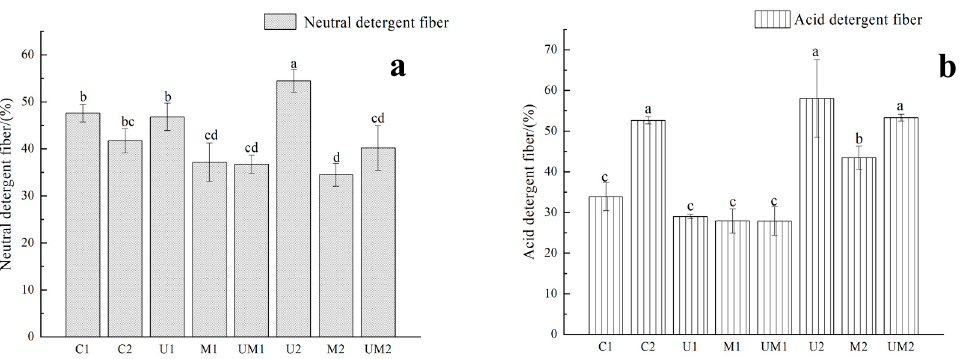
Figure 5. Effect of additives on the contents of NDF ( a ) and ADF ( b ) in mixed silage. Note: Different lowercase letters indicate significant difference between different treatment groups ( p < 0.05).